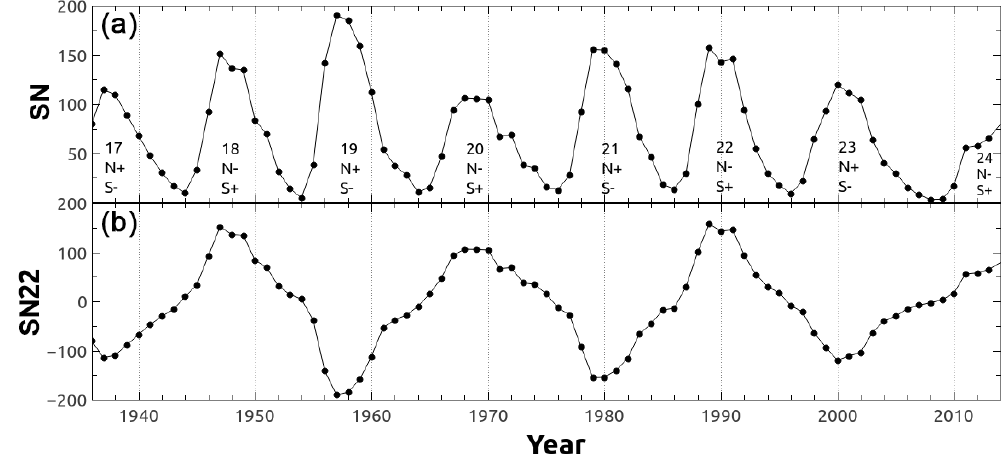
Figure 2. Time series of the sunspot cycle: (a) with solar cycles and (b) the double sunspot cycle